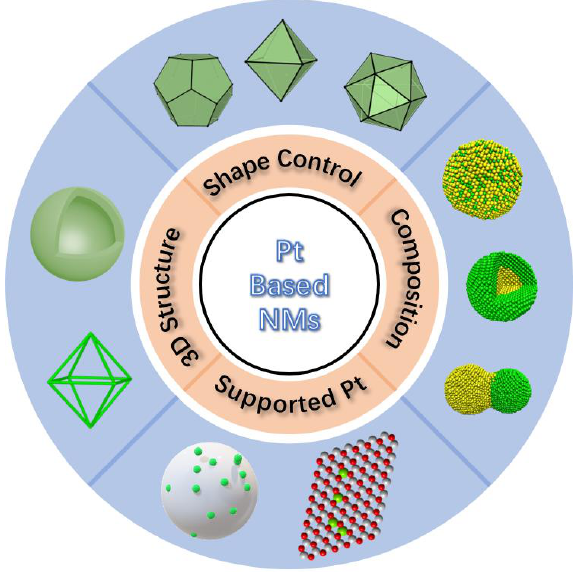
Figure 1. Schematic illustration of four ways of structural regulation of Pt-based NMs.